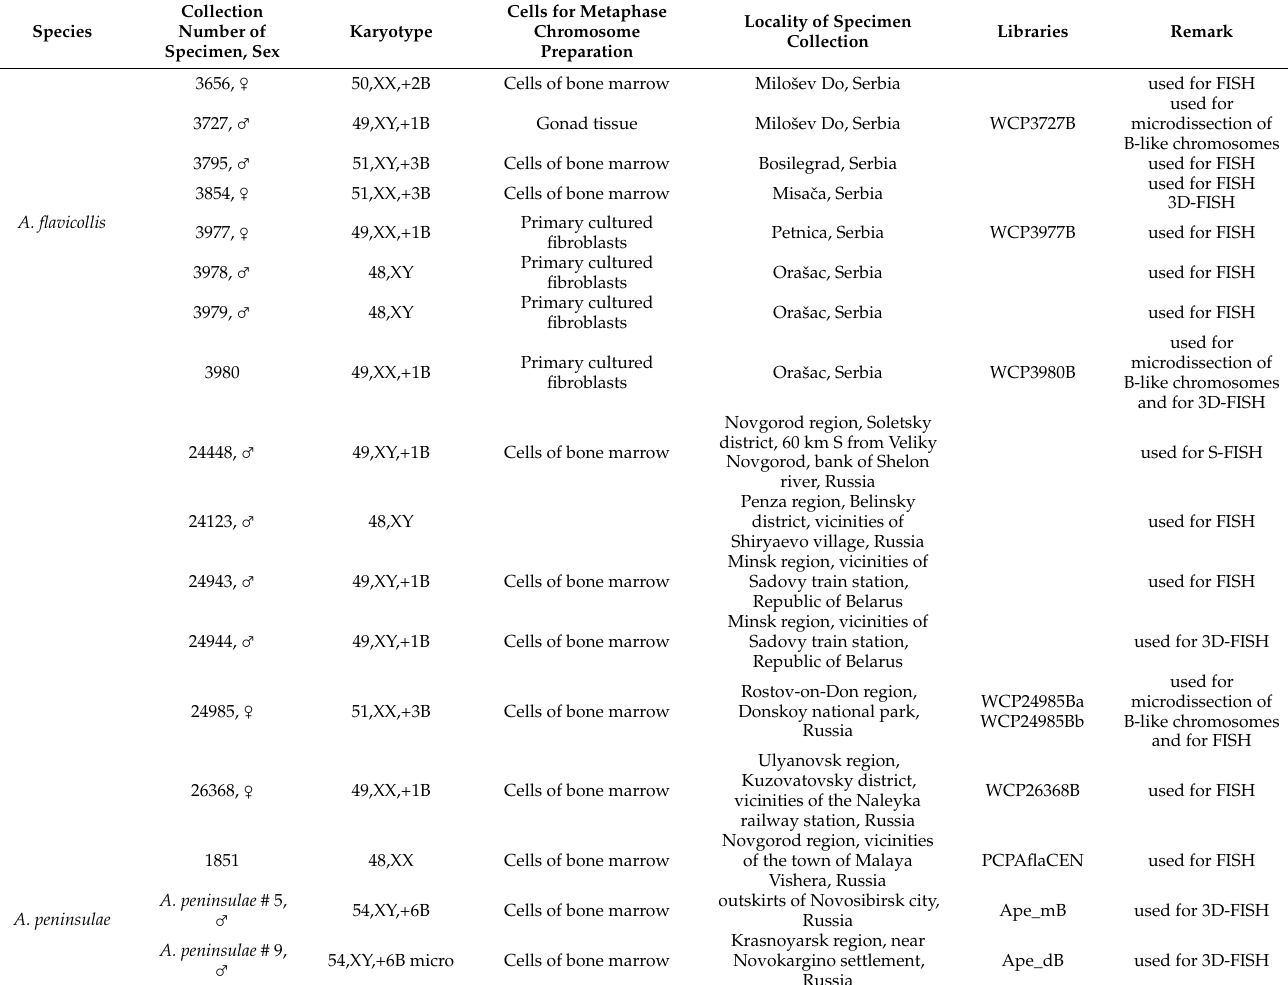
Table 1. Information about Apodemus flavicollis and A. peninsulae specimens involved in the study.